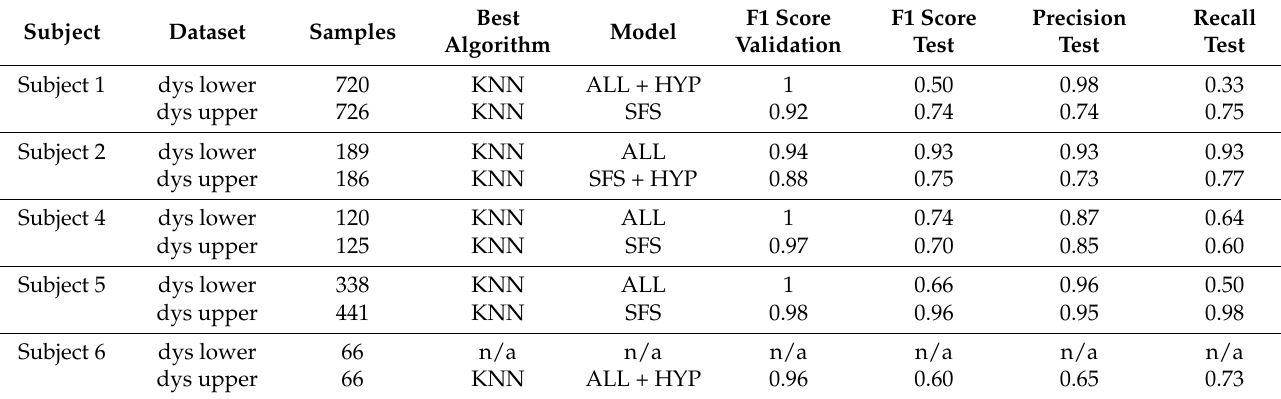
Table 4. Overview of best individual model per dataset for each